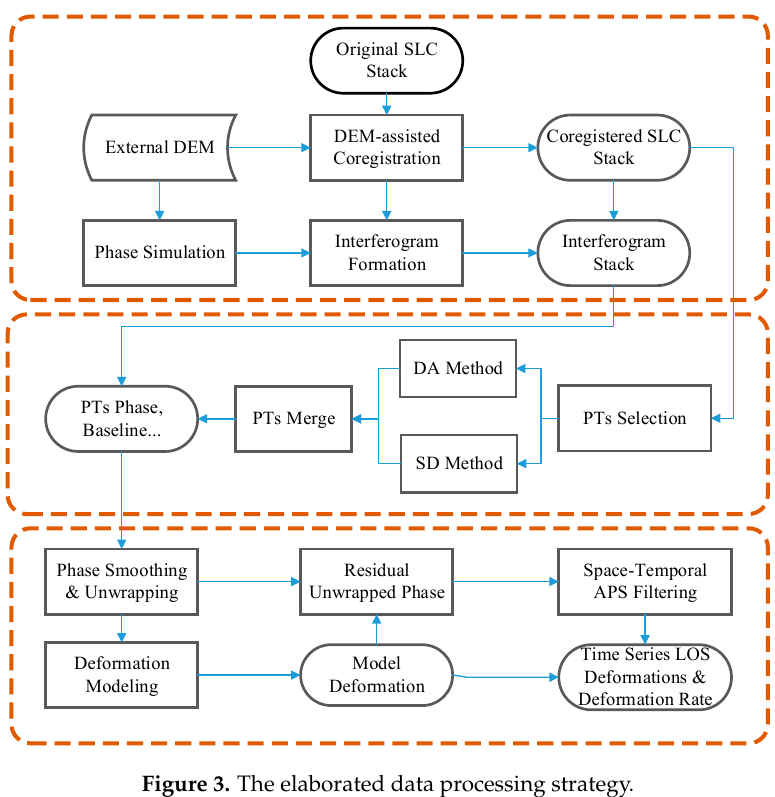
Figure 3. The elaborated data processing strategy.